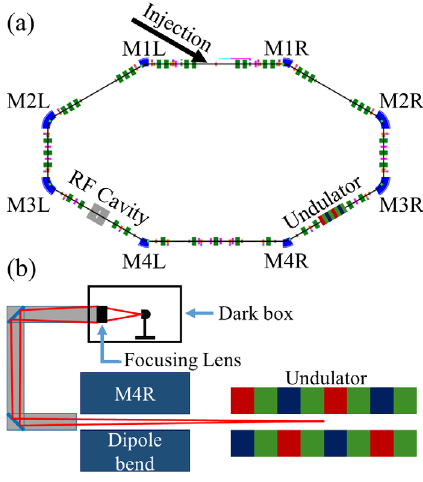
FIG. 1. (a) Layout of IOTA. (b) Light path from the undulator to the detector (not to